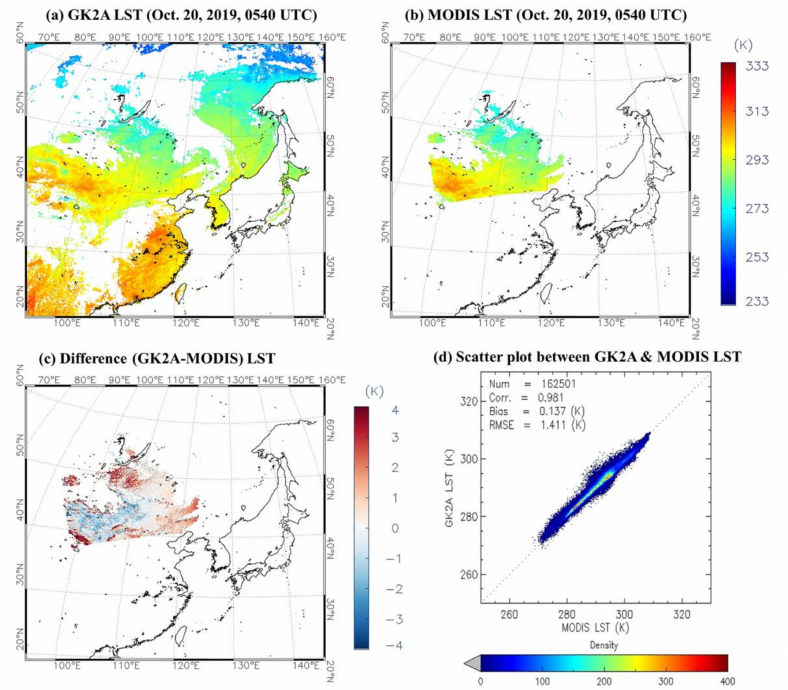
Figure 10. Spatial distribution of ( a ) GK2A LST, ( b ) MODIS (MYD11_L2) LST, ( c ) di ff erences between the GK2A and MODIS LSTs, and ( d ) scatter plot between the GK2A and MODIS (MYD11_L2) LSTs for 20 October 2019, 0540 UTC (gray dotted line in ( d ) represents the 1:1